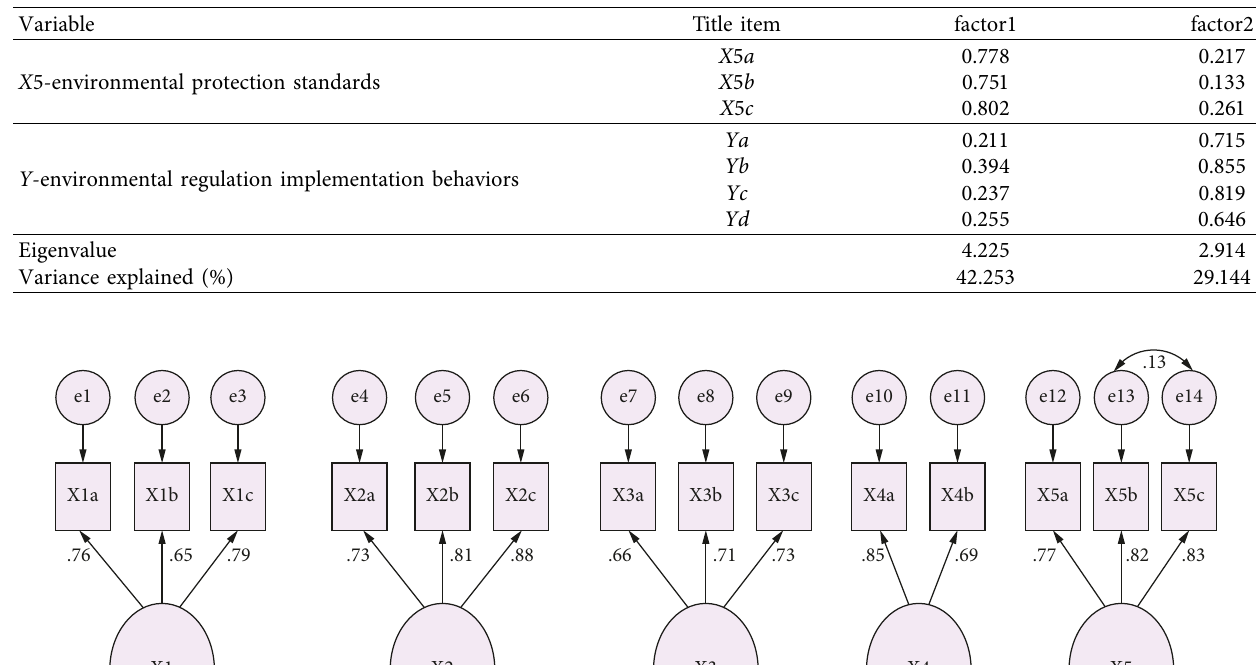
Table 7: Exploratory factor analysis results of enterprises.